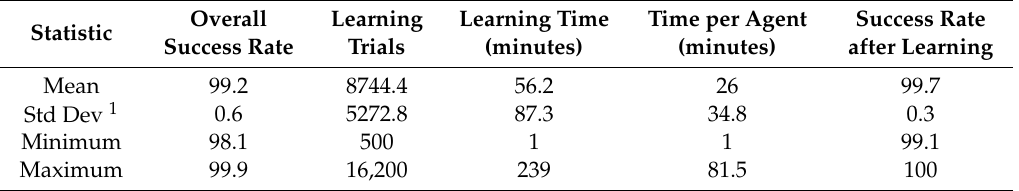
Table 6. Basic statistics of goodness-of-fit indicators for the proposed model in each of the simulations.